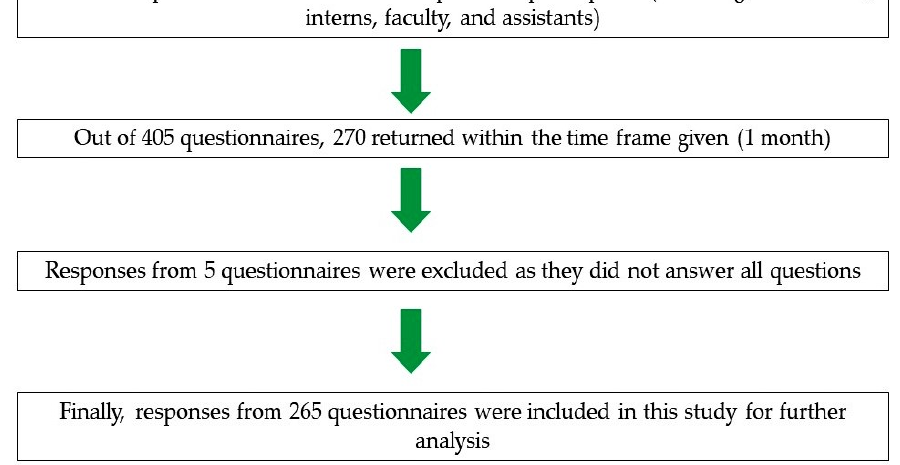
Figure 1. Flow chart showing the participant recruitment process of our study.